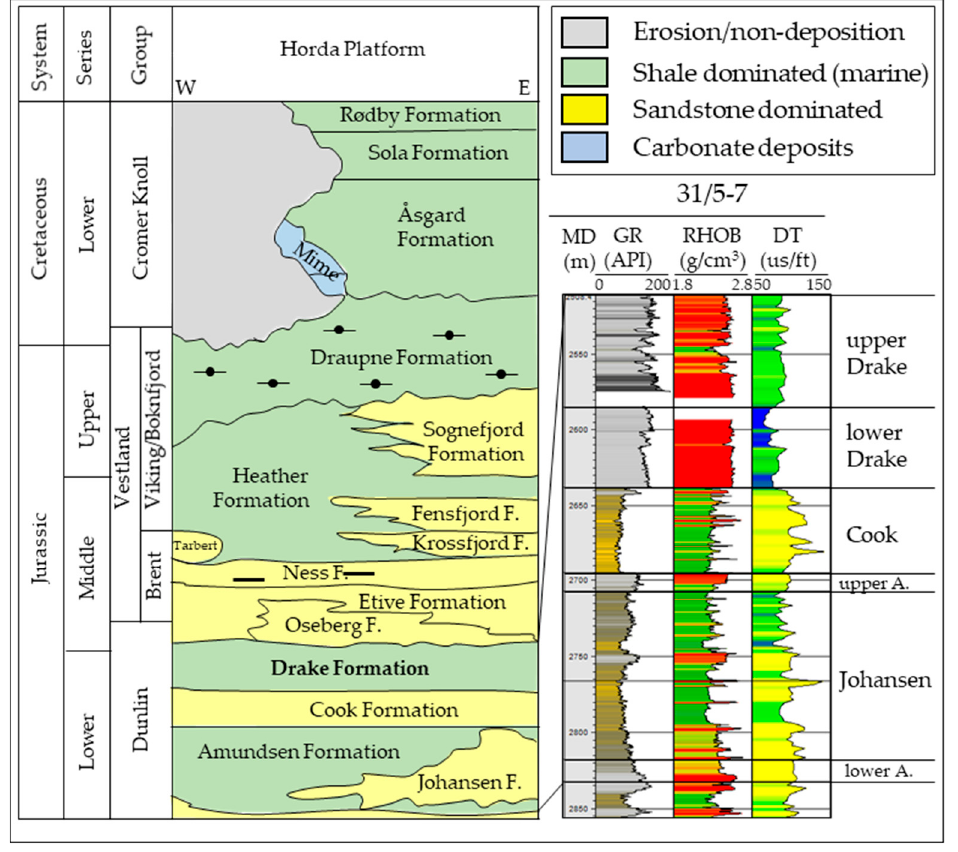
Figure 3. A generalized Jurassic and Cretaceous stratigraphic succession of the study area (modified after NPD, [46]). The presented chronostratigraphy of Horda Platform has no scale, but the sandstone pinching out indicates relative east (E) and west (W) directions of the studied area. Wireline logs such as gamma-ray (GR), density (RHOB), and P-sonic (DT) of the Dunlin Group from well 31/5-7 are also shown. Note that the Drake and Amundsen formation shales are divided into upper and lower units.